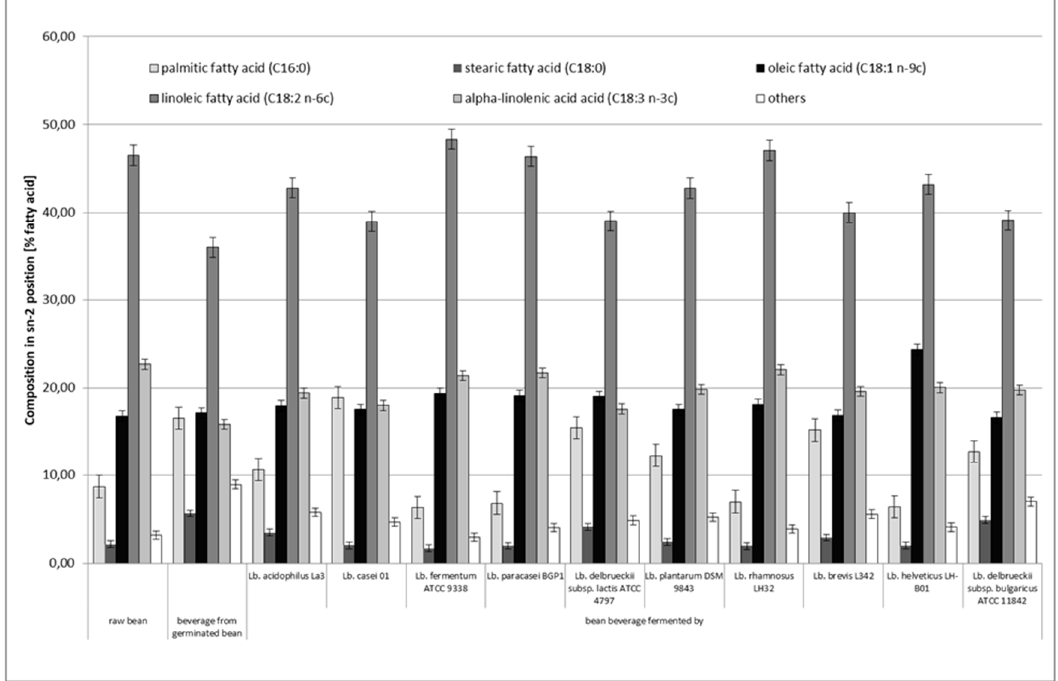
Figure 2. Positional distribution (sn–2) of fatty acids in triacylglycerols obtained from raw bean and bean–based beverages before and after fermentation process (means ± standard deviations, n = 4). Other minor fatty acids include 14:0, 16:1, 17:0, 20:0, and 22:0.